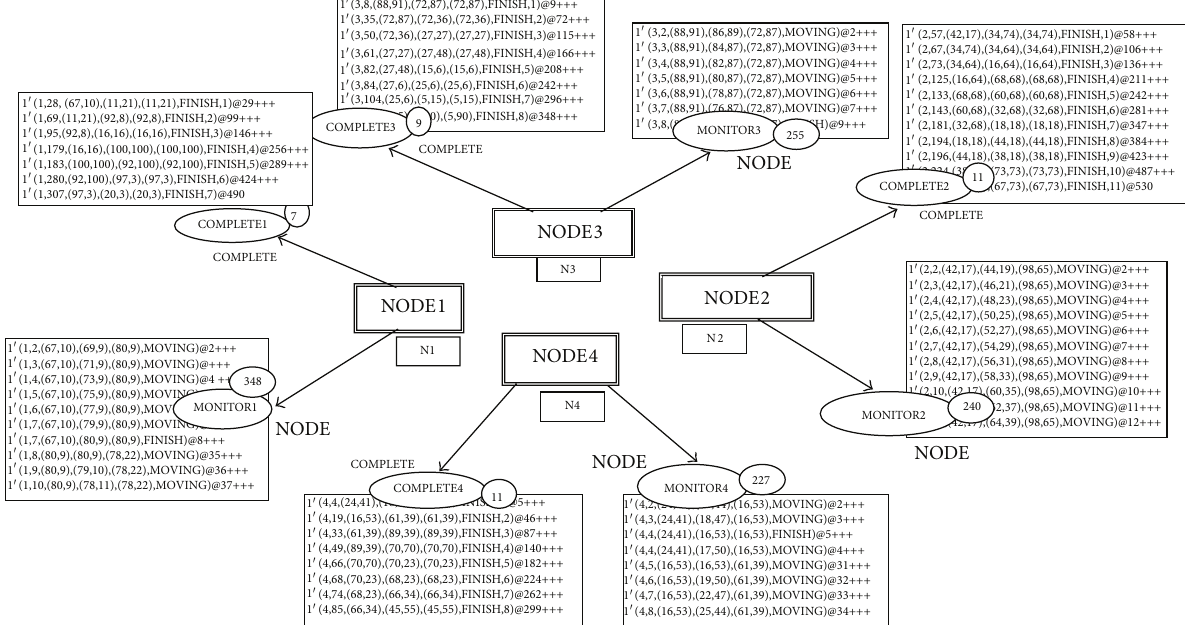
Figure 5: Traveling pattern of MH based on RWP mobility model.